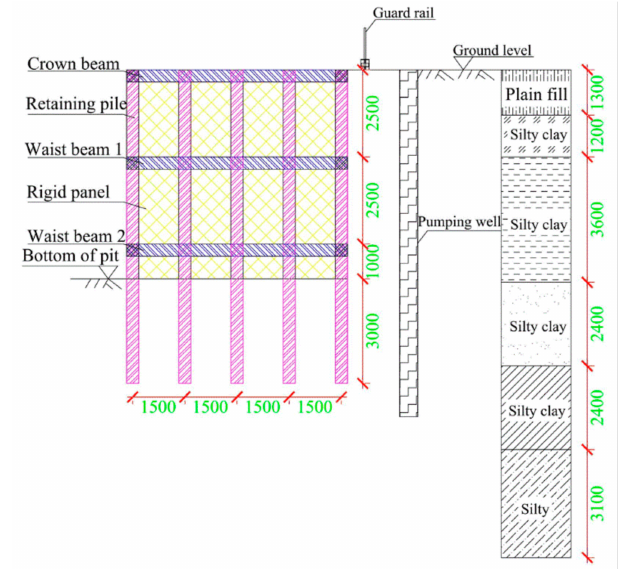
Figure 2. The profile of the foundation pit. Table 2. The physical and mechanical parameters of the supporting structure.